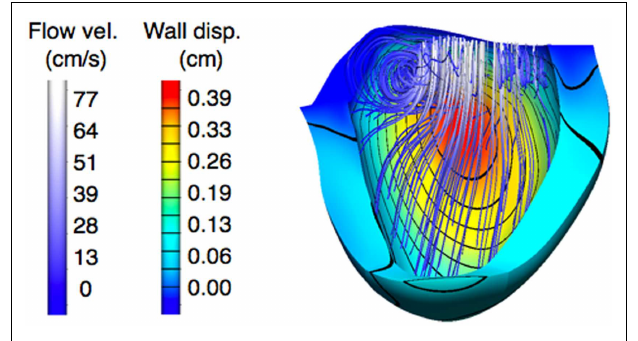
FIGURE 5 | Example of results from fluid structure interaction (FSI) simulations, providing information on displacement of the myocardium, as well as showing vortex formation and blood streamlines in a patient after Stage 1 palliation